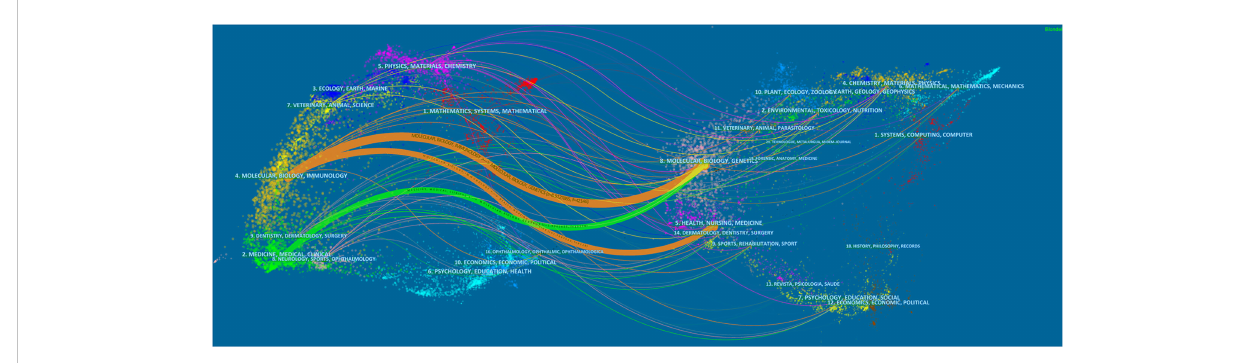
FIGURE 5 The dual-map overlay of journals related to research on tumor ablation and